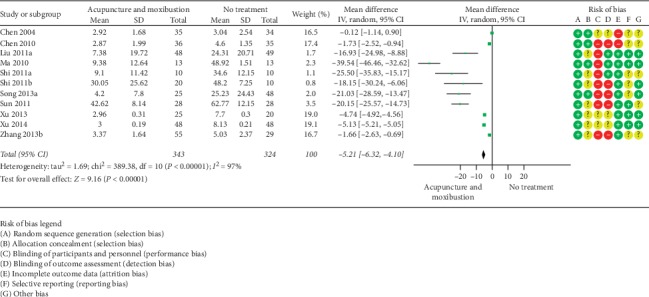
Acupuncture and moxibustion vs. no treatment.